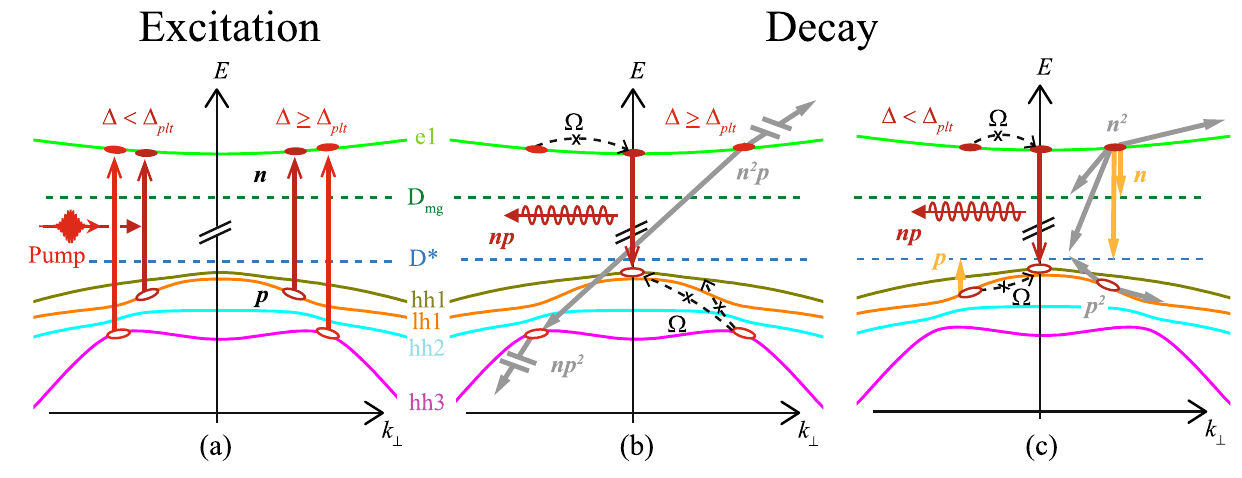
Figure 6. ( a ) Interband excitation by the optical pump creates holes ( p ) and electron ( n ) in the valence and conduction bands 15 at non-zero in-plane wavevectors. ( b ) Excitation with pulse detuning at (cid:31) ≥ (cid:31) plt results in decay by Auger-scattering [∝ n 2 p , np 2 ] , followed by intraband relaxation via phonon emission [ (cid:31) ], then ( c ) trap-assisted Auger [∝ n 2 , p 2 ] and radiative recombination [∝ np ] and finally by Shockley-Read-Hall dynamics [∝ n , p ] . Excitation with � < � plt results in decay only through the stages outlined in ( c